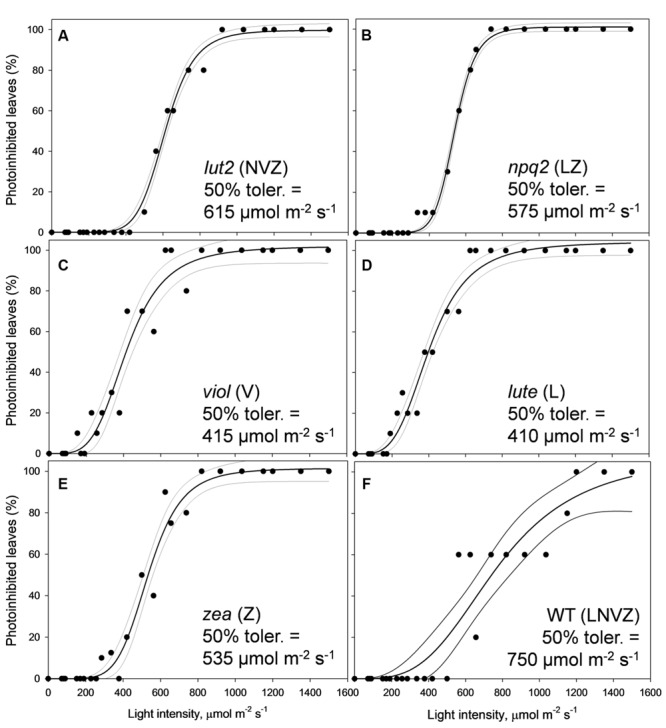
Leaf population tolerance curves calculated using the pNPQ assessment procedure in lut2(A), npq2(B), viol(C), lute(D), zea(E)Arabidopsis mutants and the wild type (F) plants. Each closed circle represents the percentage of closed reaction centers at each AL intensity. The % of photoinhibited leaves was calculated from Figure 3 as 100 × Nrhombs/Ntotal. Regression analysis and 95% confidence intervals were performed using SigmaPlot12.0 (Sigmoidal fit, Hill 3 parameter, f = a∗xˆb/[cˆb+xˆb]). lut2 – no lutein, npq2 – no violaxanthin and neoxanthin, viol – violaxanthin only, lute – lutein only, zea – zeaxanthin only, WT – wild type.